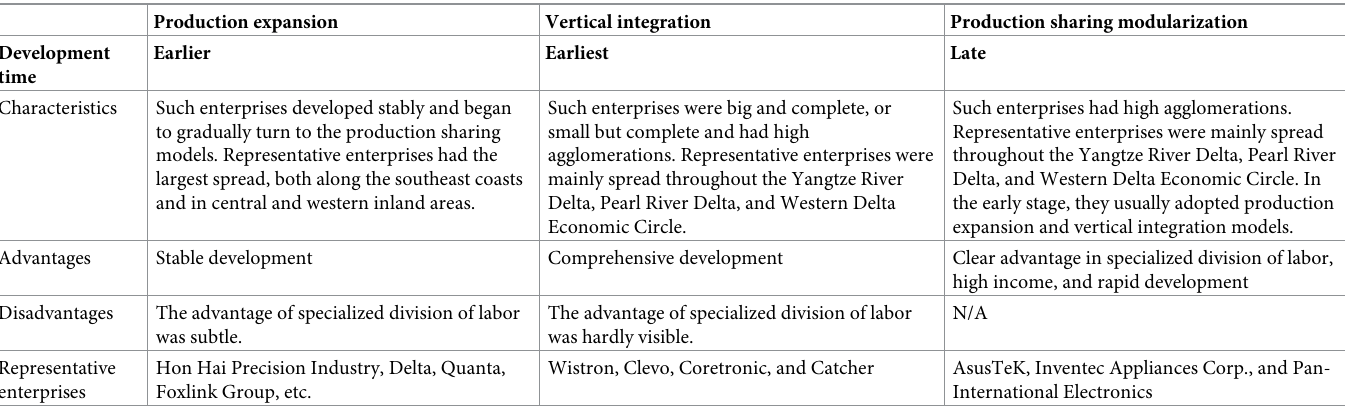
Table 2. Comparison of the three organization